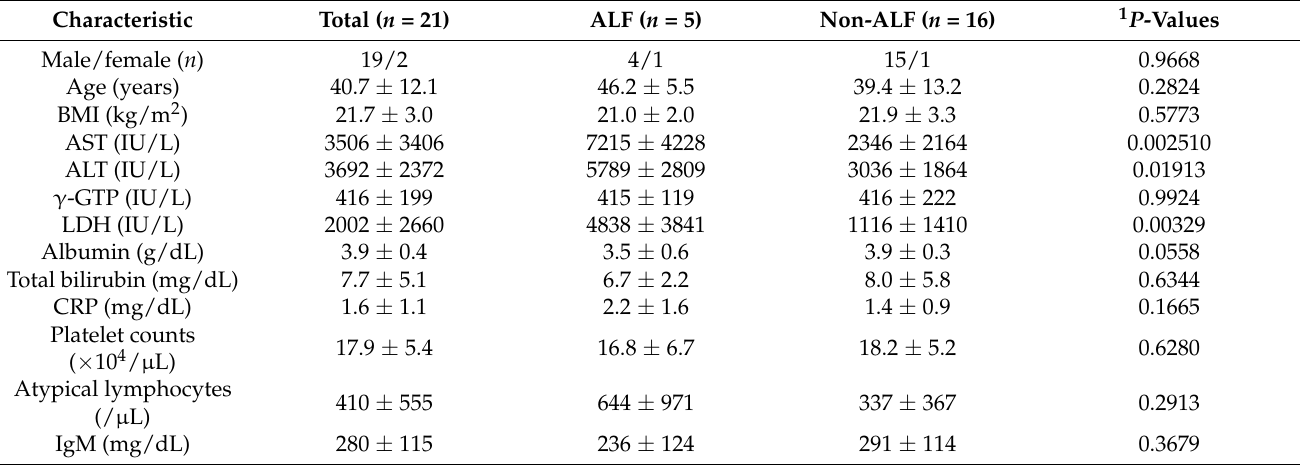
Table 1. Clinical characteristics at baseline of patients in the present